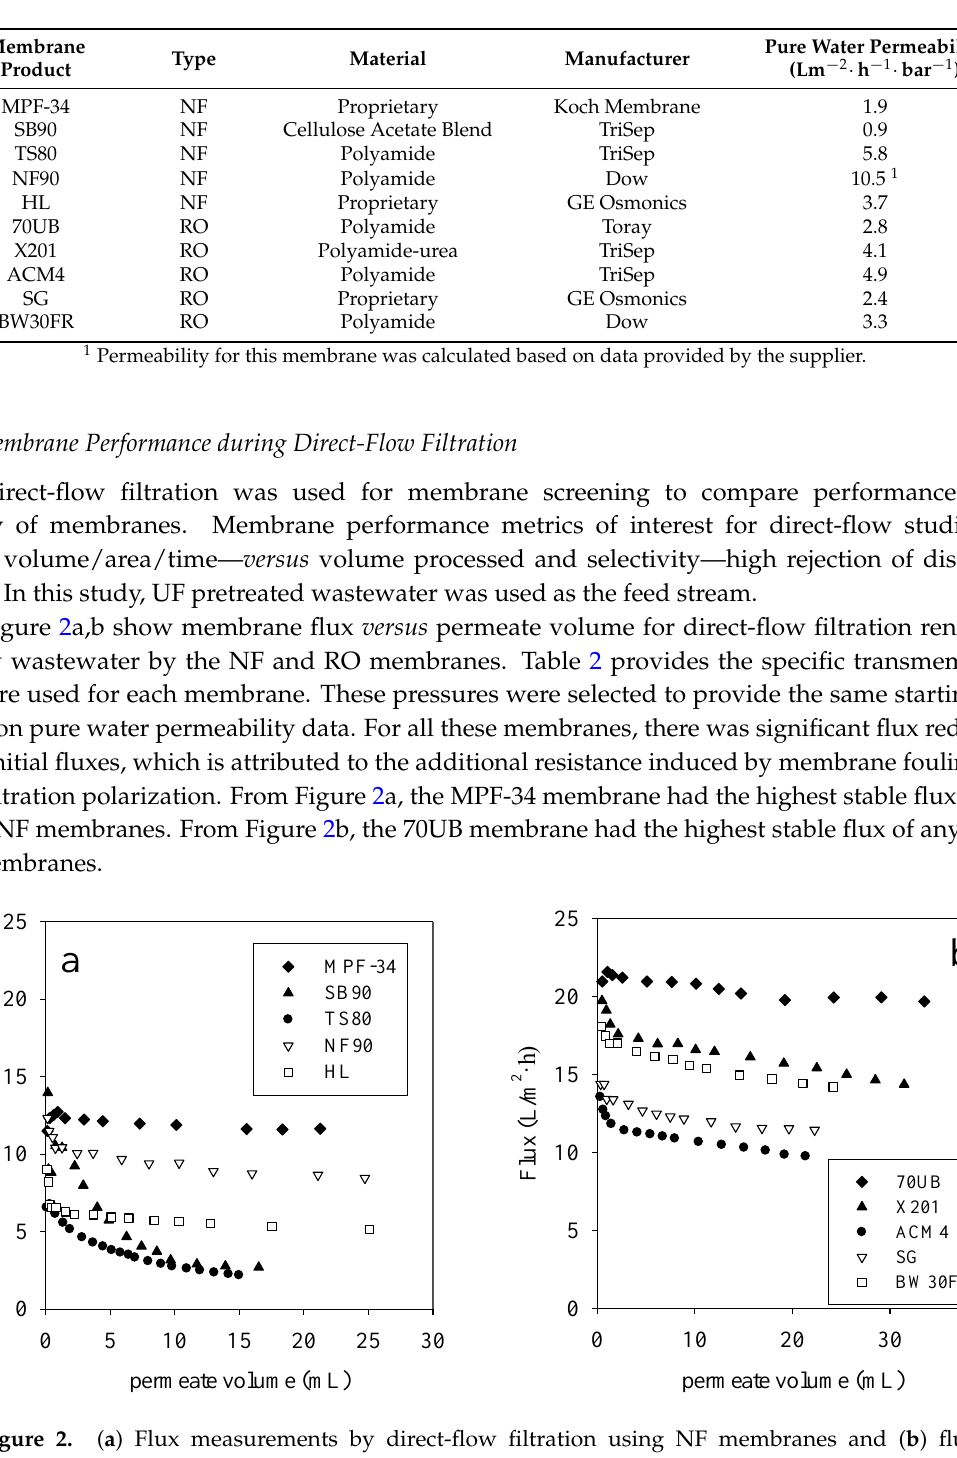
Table 1. Nanofiltration and reverse osmosis membranes used in the study.